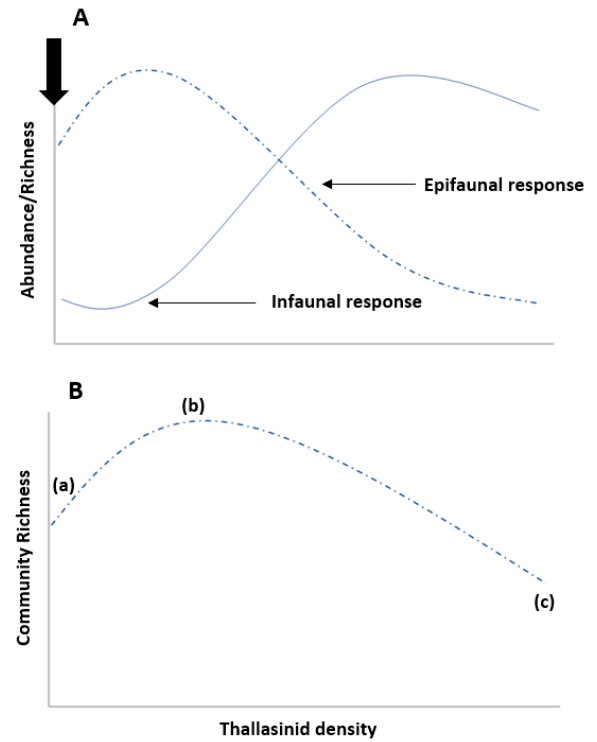
Figure 3. Predicted responses of ( A ) epi- and infaunal abundance / richness and ( B ) community richness to increasing thalassinid densities. In A, increasing thalassinid densities is expected to induce shifts from epifaunal- to infaunal-dominated states, due to increased sediment processing strengthening amensalism and facilitation on epifauna and infauna respectively. In ( B ), community richness is expected to respond unimodally to increasing thalassinid density. Thick arrow above y-axis denotes a non-engineered state. Note: responses are intended to be illustrative, not exhaustive – broad patterns are more important than specific response features.